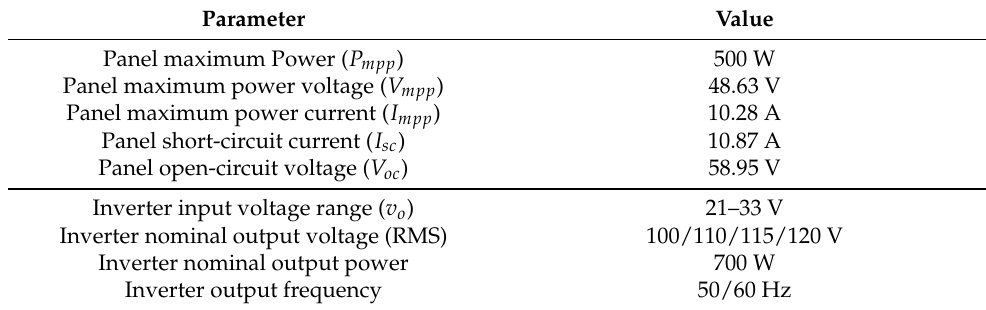
Table 1. Parameters of the SP500M6-96 PV panel and COTEK SP-700-124 inverter.